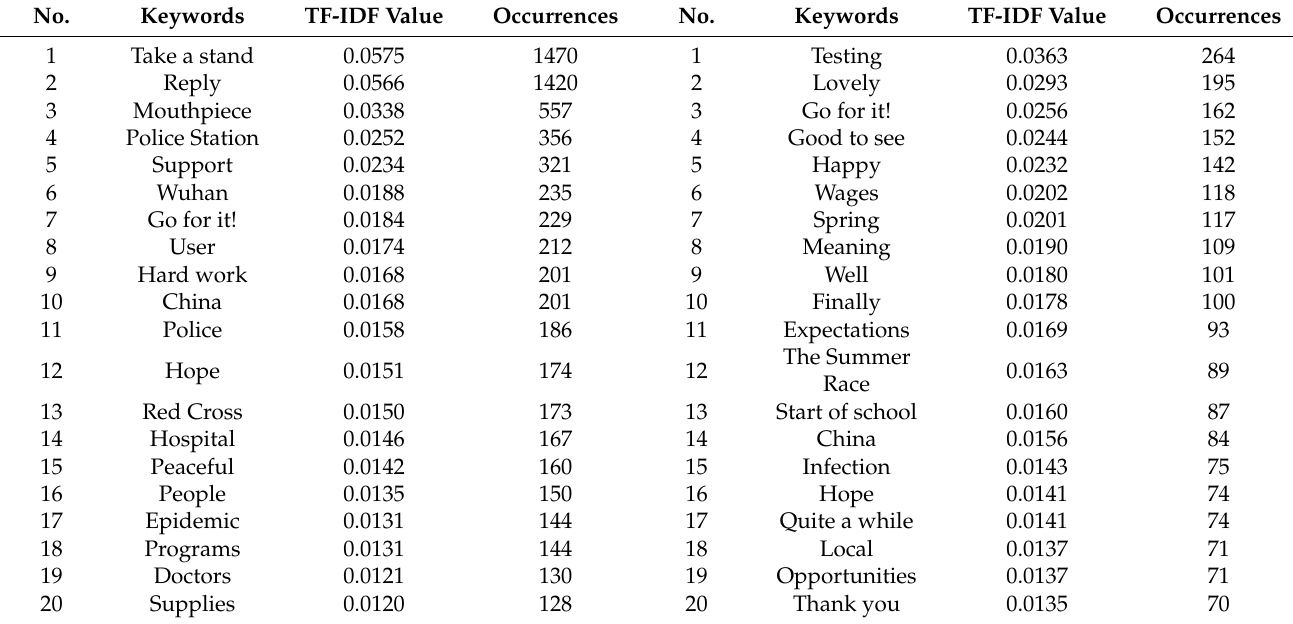
Table 2. Top 20 ranked keywords for A1 and